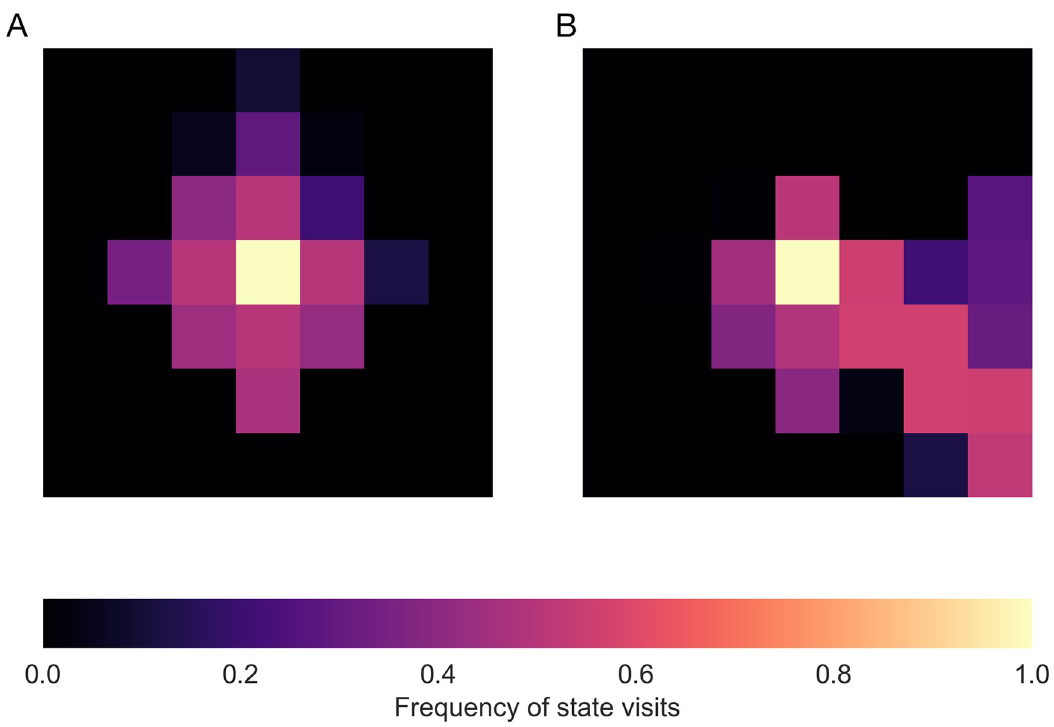
Fig 2. Grid-world pruning simulation results. Reaching the bottom-right corner of the map with minimum moves is rewarding. The heatmaps show the frequencies of state-visits during the tree expansion when the agent starts from the middle of the map, and (A) the agent has had no prior exposure to the environment, or (B) after some exposure (i.e., 10 trajectory samples from each state) resulting in more accurate estimates of model-free values.